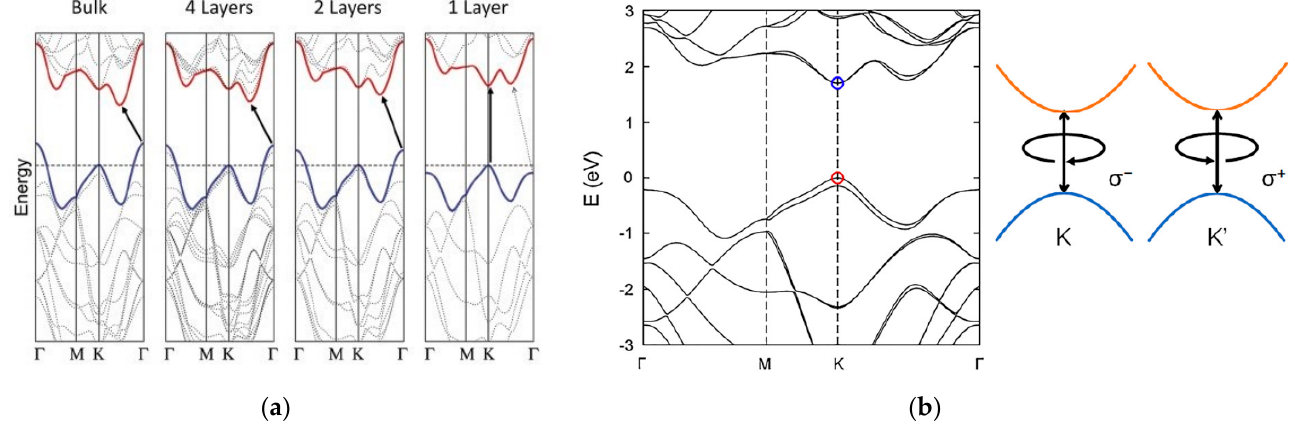
Figure 2. Energetic band structure of MoS 2 . ( a ) Transition from indirect to direct band gap moving from the bulk MoS 2 to the single layer of MoS 2 . Reprinted with permission from ref. [15]. © 2010, American Chemical Society. ( b ) Degeneracy at the K point in the valence band of a single MoS 2 layer. Reprinted with permission from ref. [6]. © 2017, AIP Publishing.